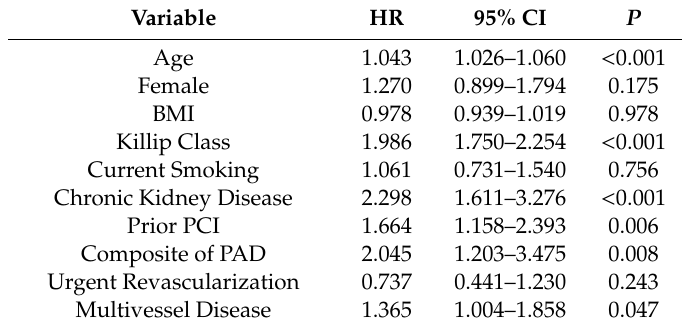
Table 3. Multiple regression analyses for predicting all-cause mortality in the Type 1 MI Group.